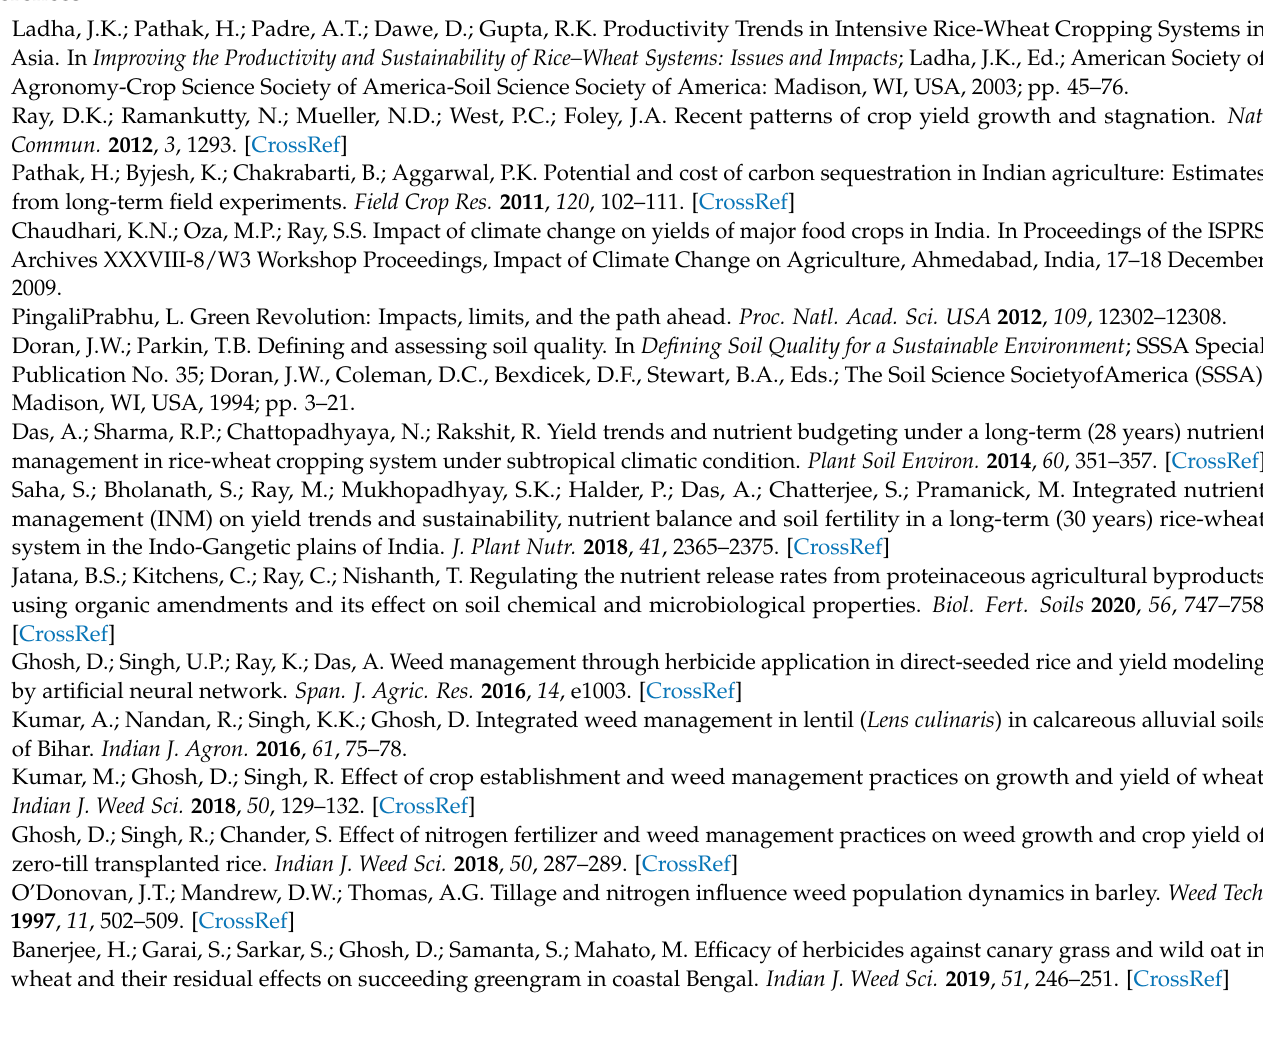
Supplementary Materials: The following are available online at https://www.mdpi.com/2073-439 Table S2: Energy calculation for maize production system/hectare, Table S3: Energy utilized through different nutrient and weed management practices in maize production system/hectare, Table S4: Energy calculation for green gram production system/hectare, Table S5: Energy utilized through dif- ferent nutrient (residual) and weed management practices in green gram production system/hectare, Table S6: Energy calculation for rice production system/hectare, Table S7: Energy utilized through different nutrient and weed management practices in rice production